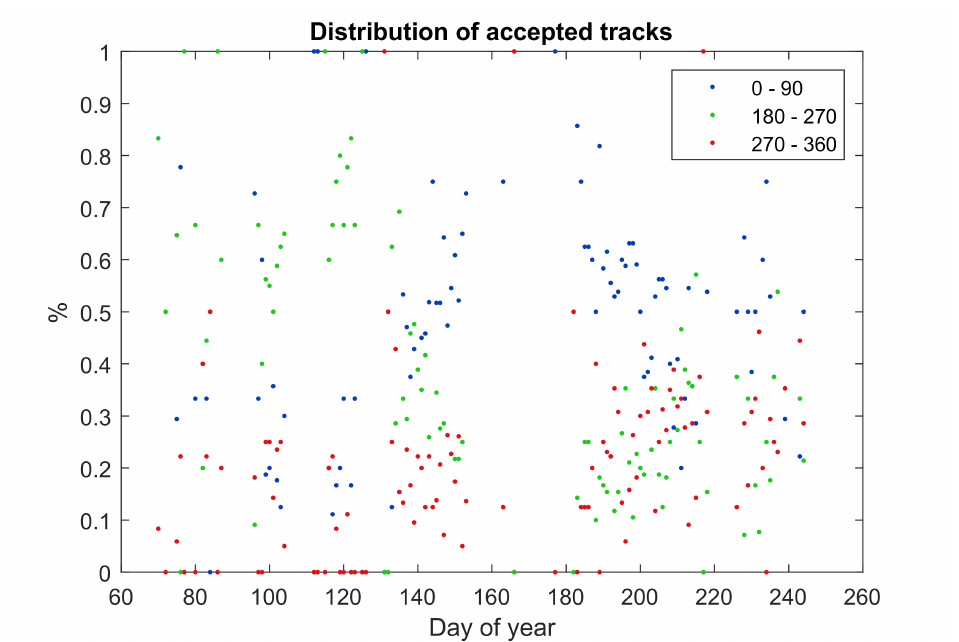
Figure 6. Azimuthal distribution of accepted satellite tracks for